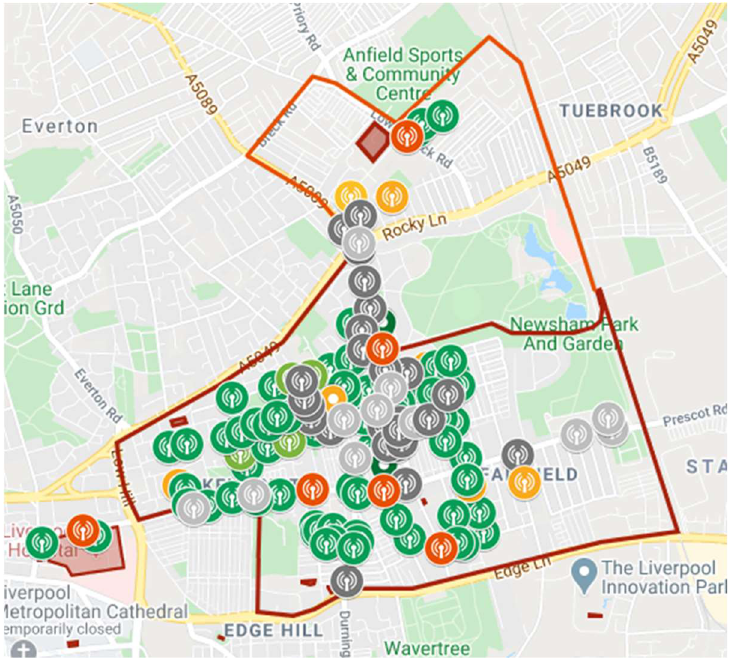
Figure 1. Overview of Liverpool 5G Backhaul Deployment.